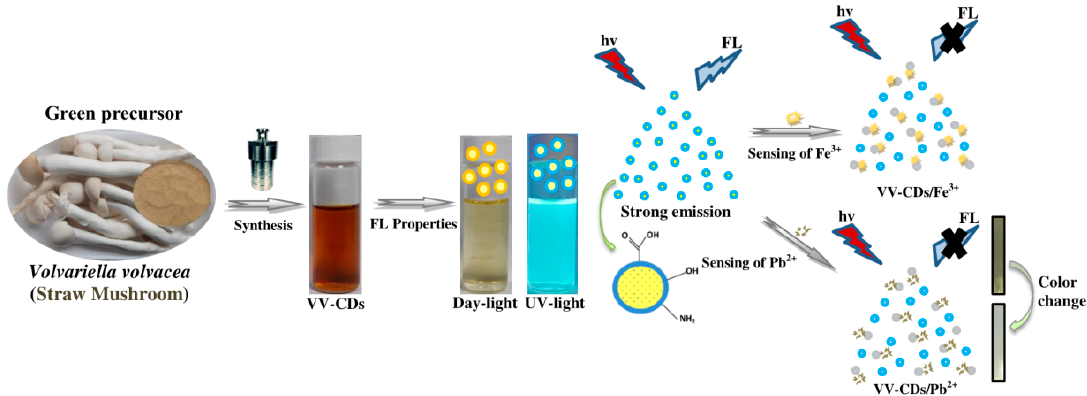
Figure 1. The schematic synthetic procedure, fluorescent (FL) properties, and application of Volvariella volvacea (VV)-carbon dots (CDs) for Fe 2+ and Pb 2+ ions.